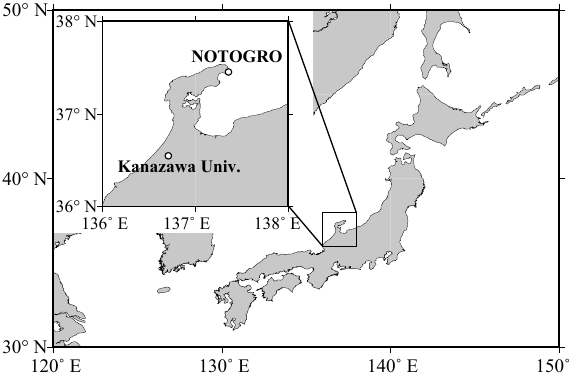
Figure 2. Sampling location of atmospheric particles (Kanazawa University) and location of the observatory for particle concentra- tion monitoring (NOTO Ground-based Research Observatory: NO-